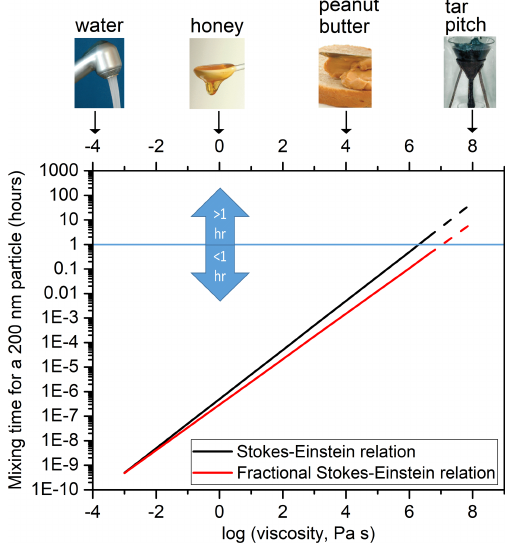
Figure 4. Mixing times of organic molecules within a 200nm par- ticle as a function of viscosity using the Stokes–Einstein relation (black line) and a fractional Stokes–Einstein relation (red line). The dashed lines indicate that the relations were extrapolated to viscosi- ties beyond the tested range of viscosities ( ≥ 4 × 10 6